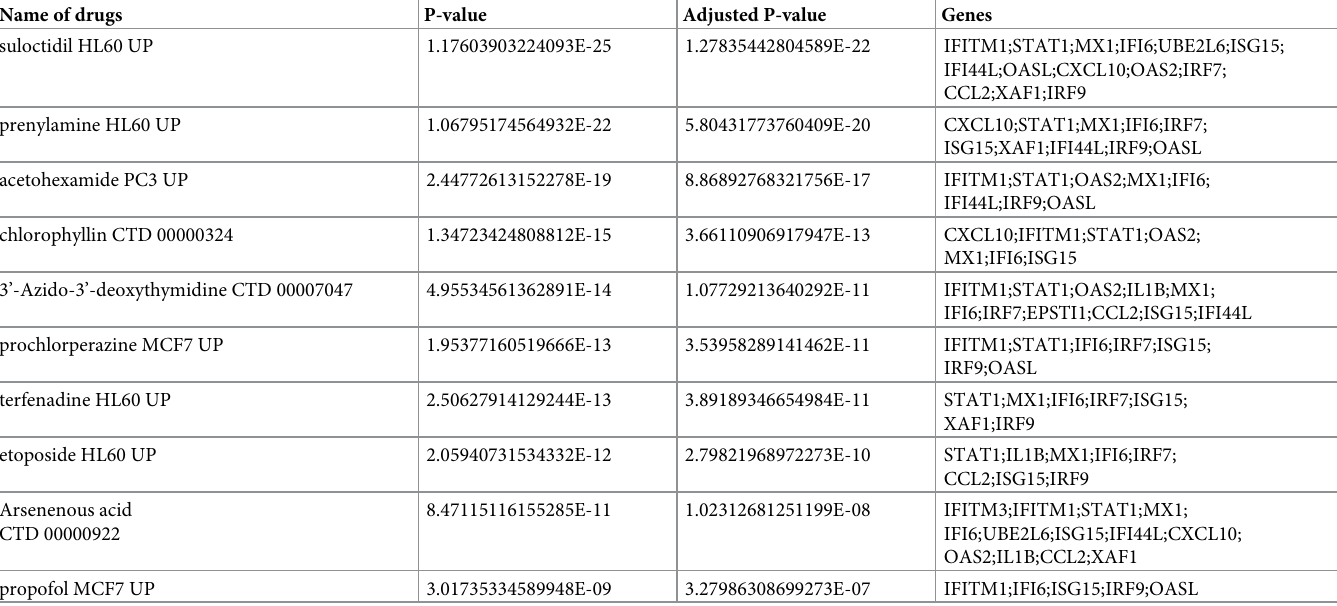
Table 3. Prediction of TOP 10 candidate drugs for high expressed hub